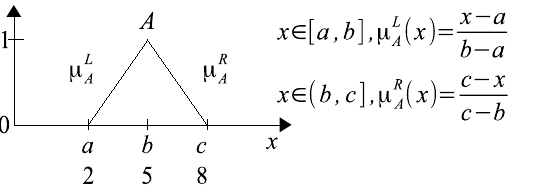
Figure 6. Visualization of a triangular T2FS according to the border definition of T2FS (12).